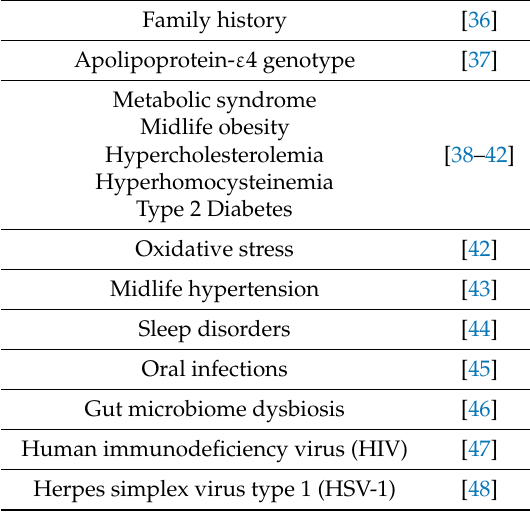
Table 2. Main factors increasing the risk of SAD /